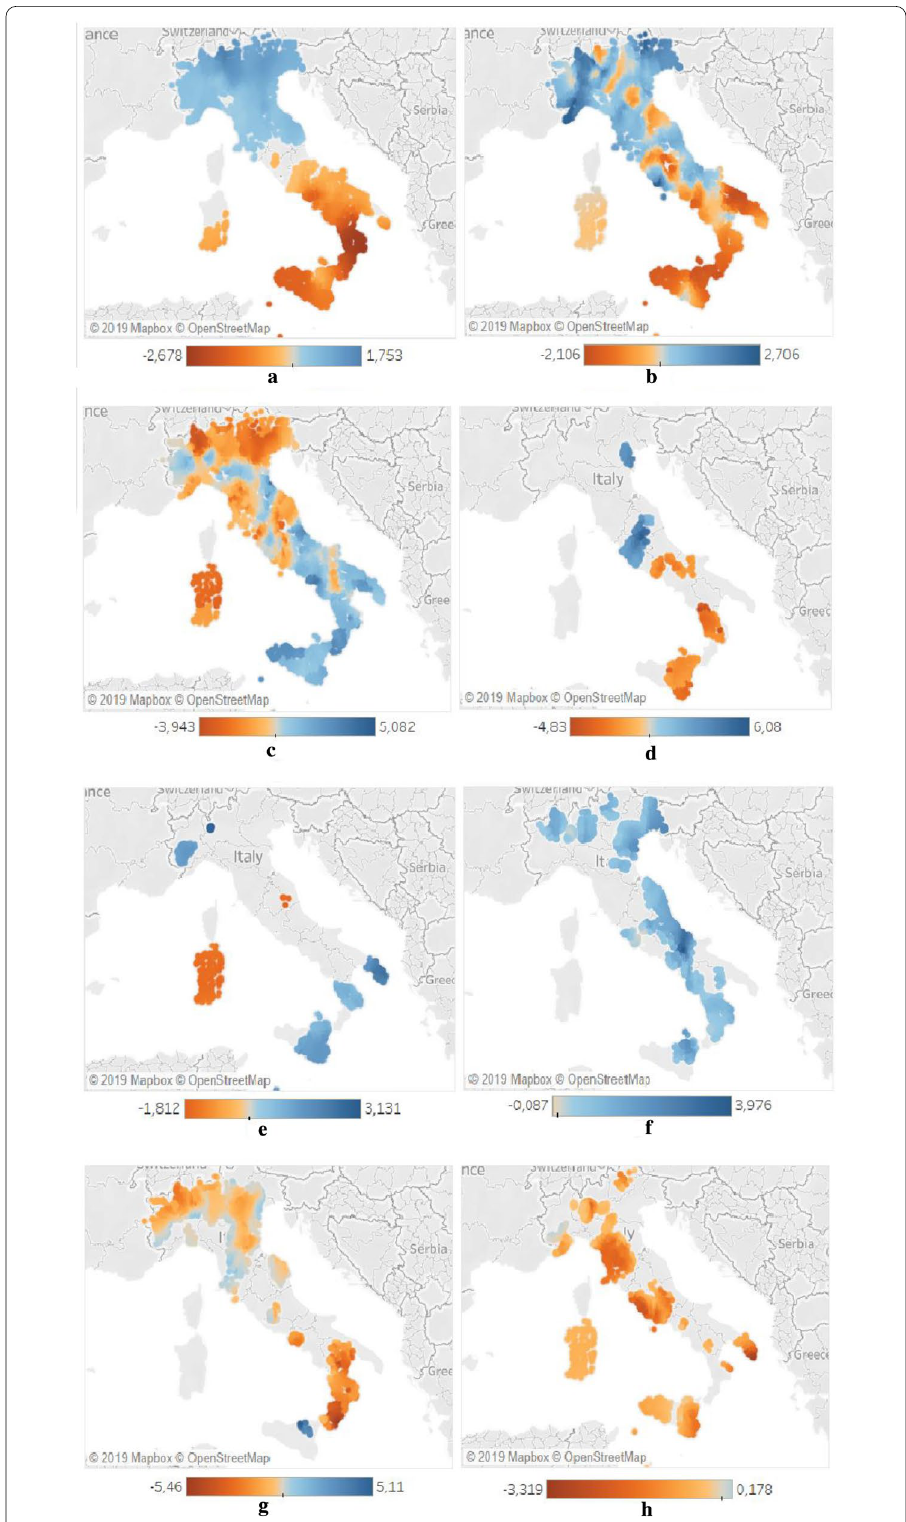
Fig. 2 Graduated colour figures of local coefficient estimates: intercept ( a ), WLE in G05 ( b ), ESCS ( c ), number of classes ( d ), number of buildings ( e ), percentage of females ( f ), percentage of immigrant students ( g ), percentage of late-enrolled students ( h